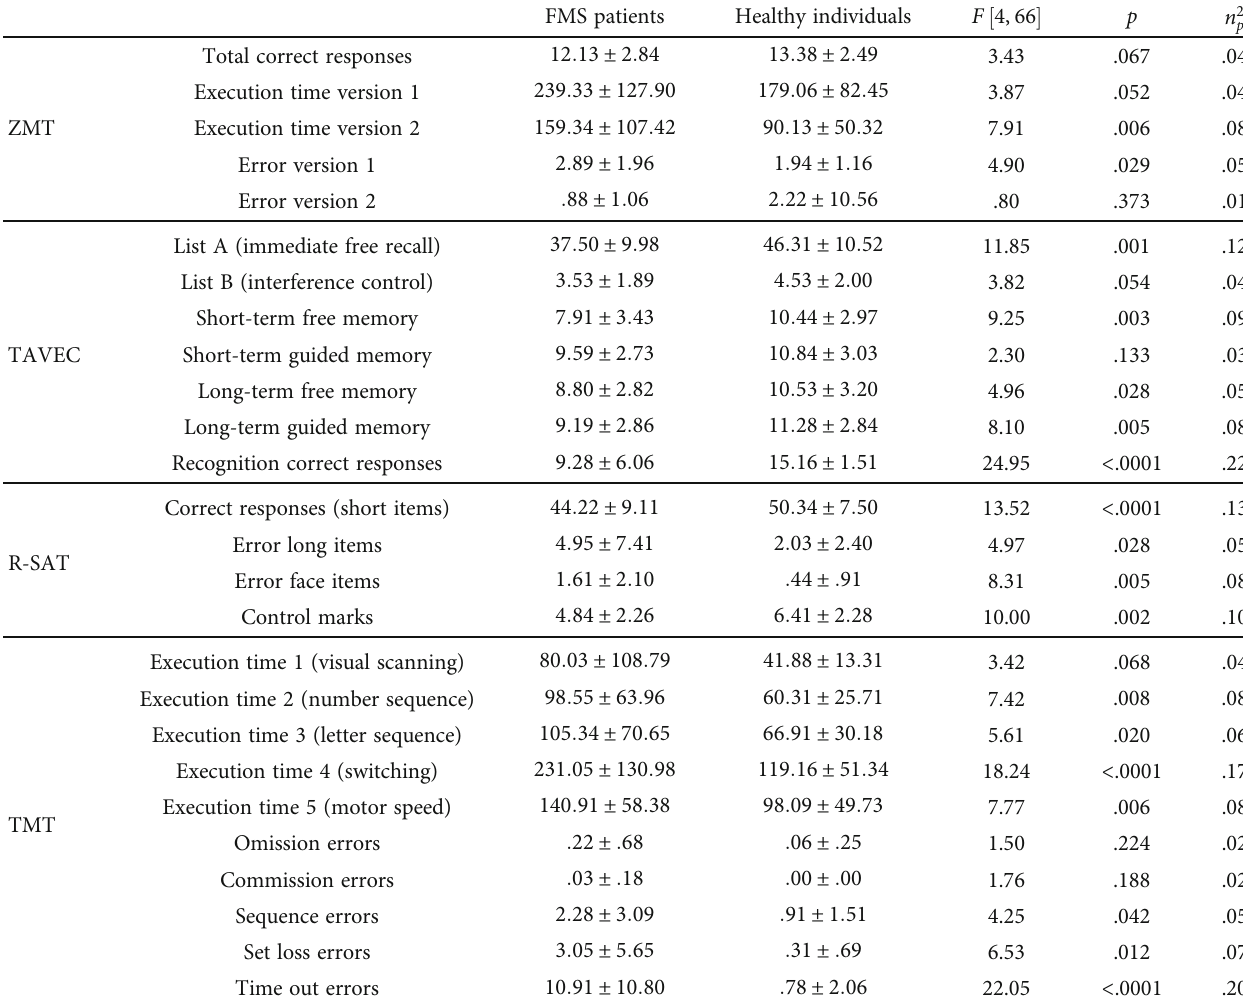
Table 2: Mean ( ± SD) of neuropsychological test scores of FMS patients ( N = 64 ) and healthy individuals ( N = 32 ) and statistics of the univariate group